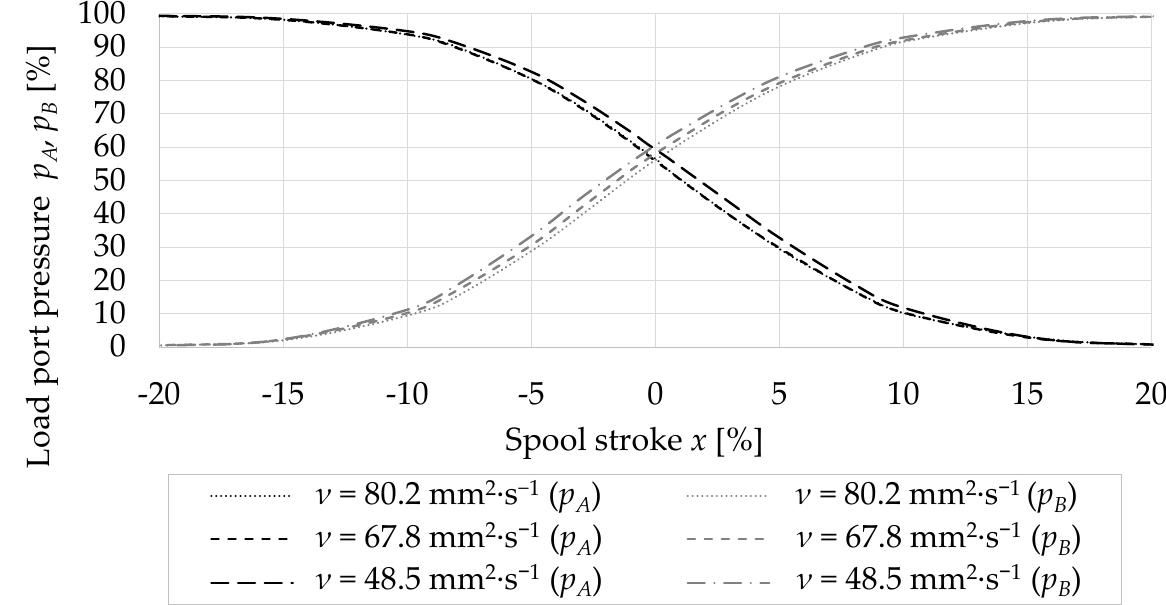
Figure 7. Blocked-line pressure sensitivity curves for different oil temperatures.